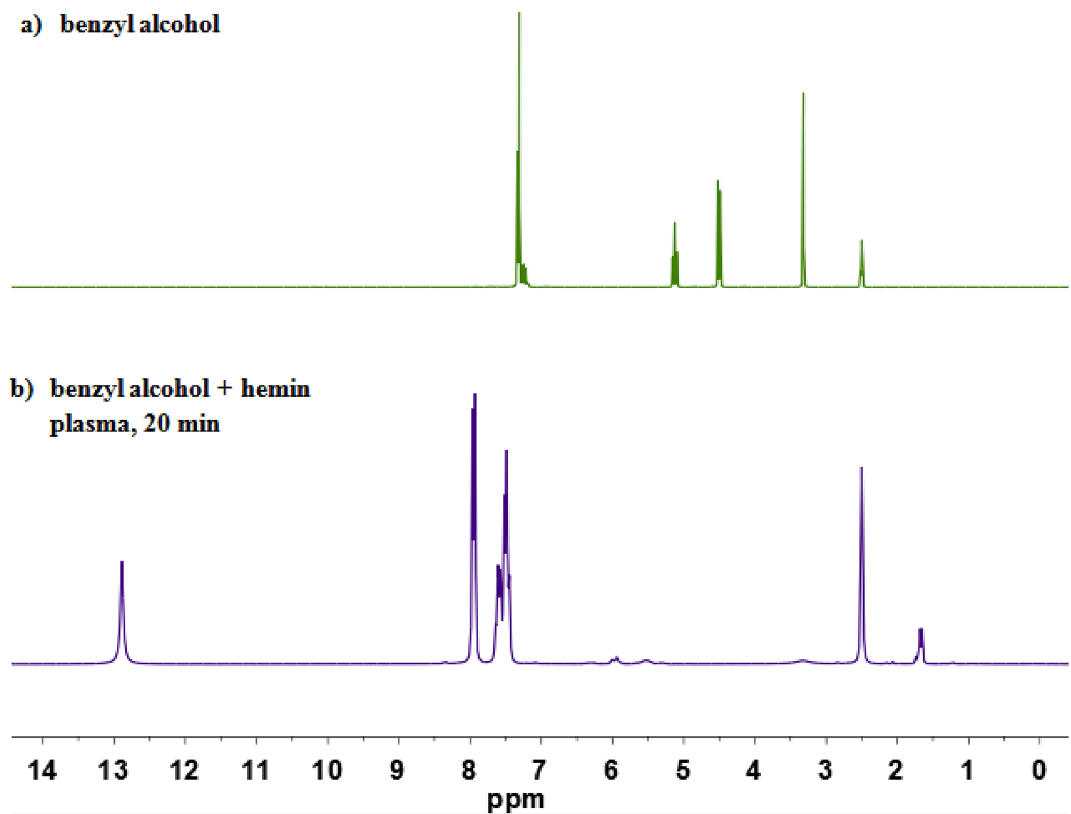
1 H NMR Figure 4. spectrum of ( a ) benzyl alcohol, ( b ) benzyl alcohol after 20 min of plasma treatment in the presence of complex B (both spectra recorded in